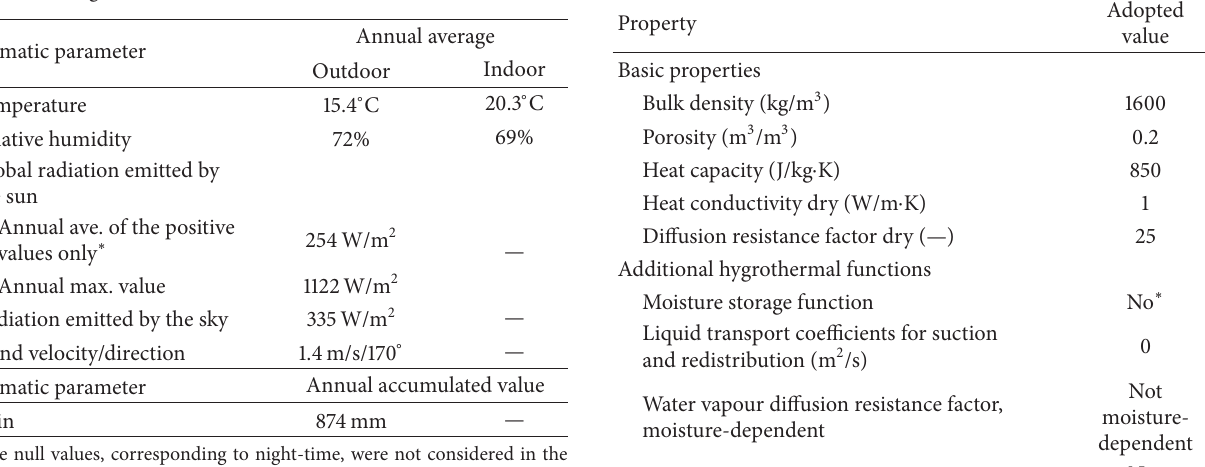
Table 1: Outdoor and indoor climate during the test campaign (annual average).